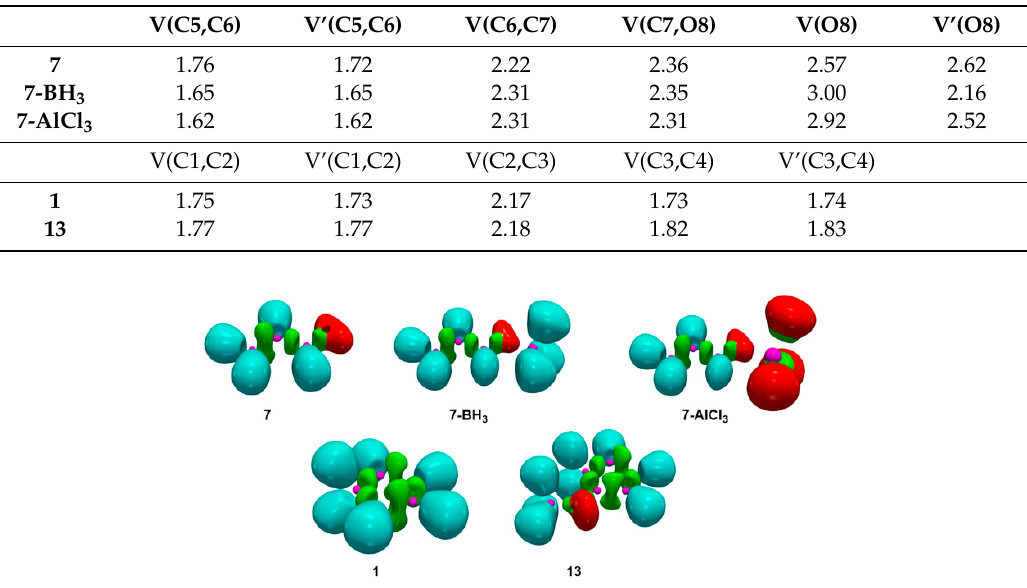
Figure 4. B3LYP/6-31G(d) ELF localization domains, represented at an isosurface value of ELF = 0.75, of 7 , 7-BH , 7-AlCl , 1 , and 13 . 3 3